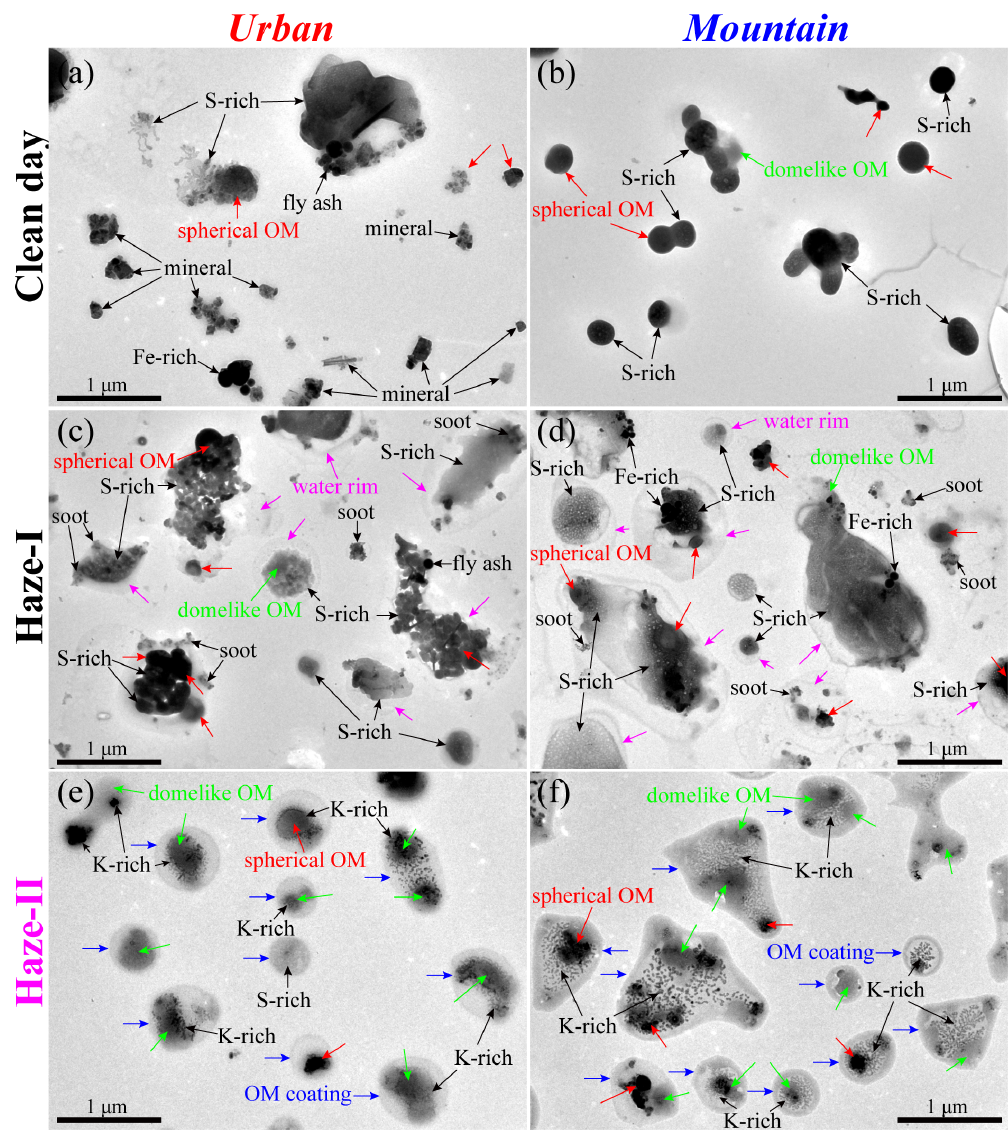
Figure 6. Typical TEM images of individual aerosol particles at low magnification at the urban and mountain sites: (a, b) clean day; (c, d) Haze-I; (e, f) Haze-II. The red, green, blue, and pink arrows represent spherical OM, domelike OM, OM coating, and water rim,